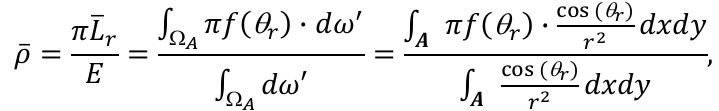
Figure 3. Geometry diagram of the oblique-looking sensor. The downward-looking sensor, mounted at height H with an oblique off-nadir angle α or around 55°, has an ellipse footprint with semi-major axis a , and semi-minor axis b . A reflection beam, with an angle θ normal of the small area dA , reaches the sensor at a distance r . The yellow arrow shows the direct incoming light, which is added to the diffuse light from the upper